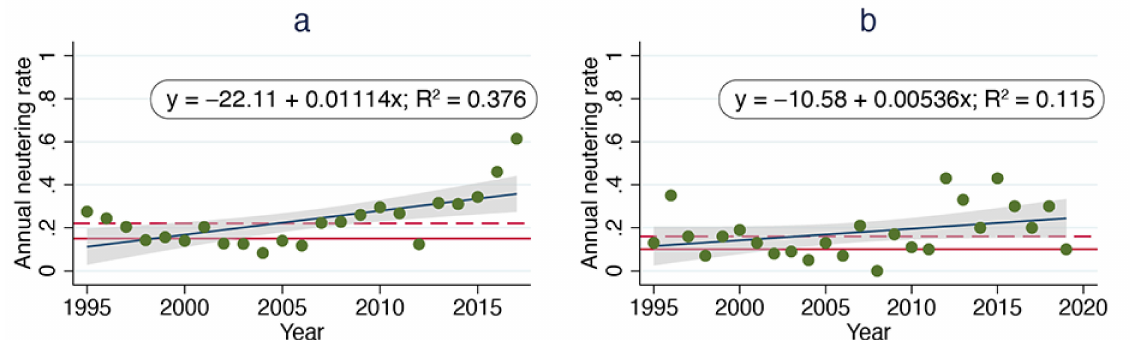
Figure 7. Observed annual neutering rates over time, ORCAT program 1995–2016 ( a ) and UCF program 1995–2018 ( b ). Dark blue lines are best-fit lines derived from linear regression; solid red lines represent critical annual neutering rates; broken red lines represent median annual neutering rates.